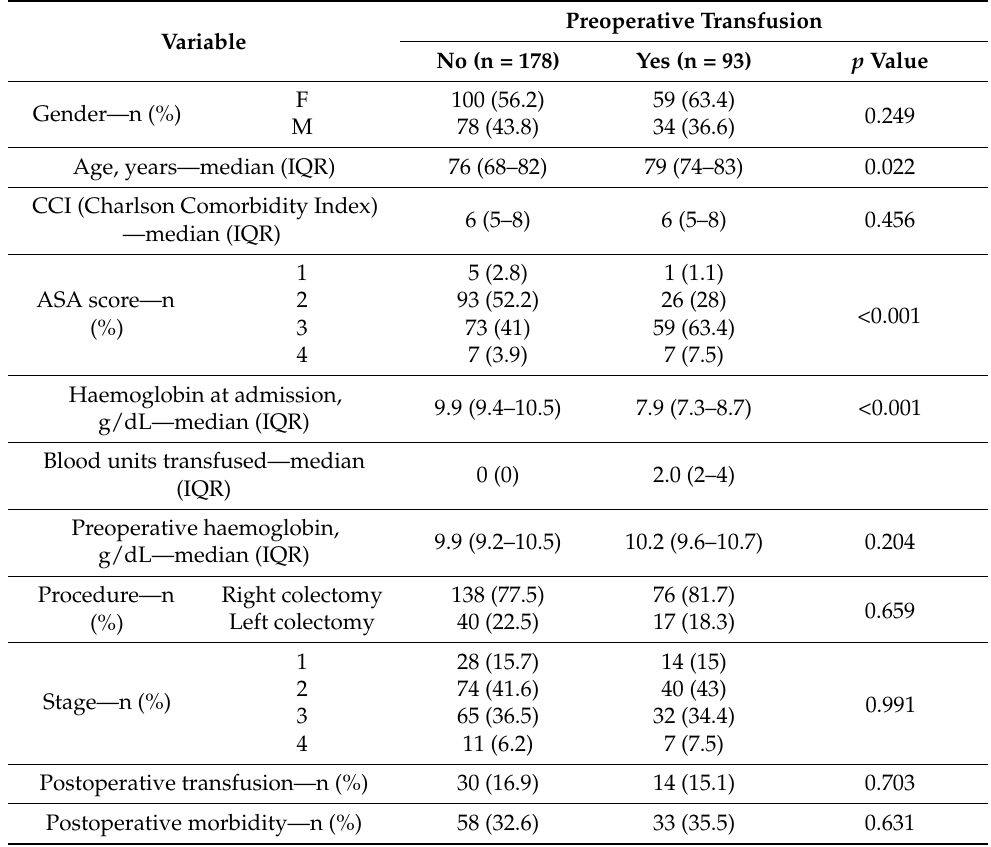
Table 3. Baseline characteristics of patients with moderate to severe